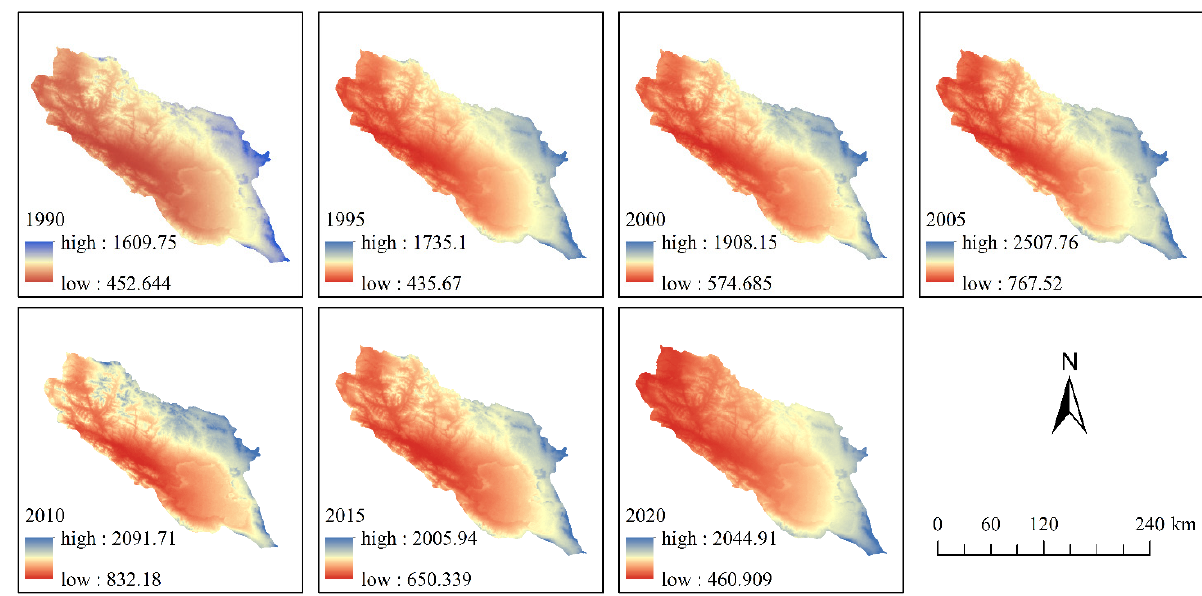
Figure 3. Distribution of rainfall erosivity in the QLB.